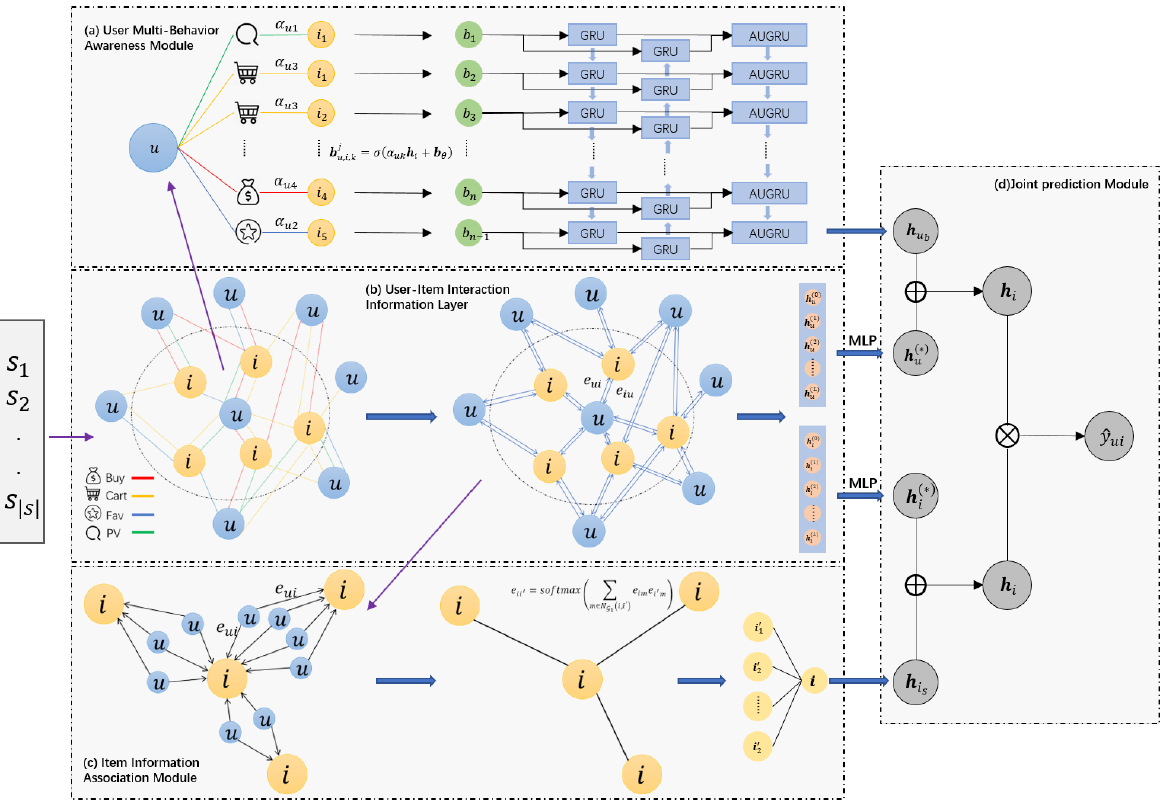
Figure 1. The framework of the UMBGN model. It contains four modules: module ( a ) is used to extract user multi-behavior interaction information, module ( b ) is used to extract user long-term multi-behavior preferences, module ( c ) is used to extract association information between items, and module ( d ) is used to output the result.